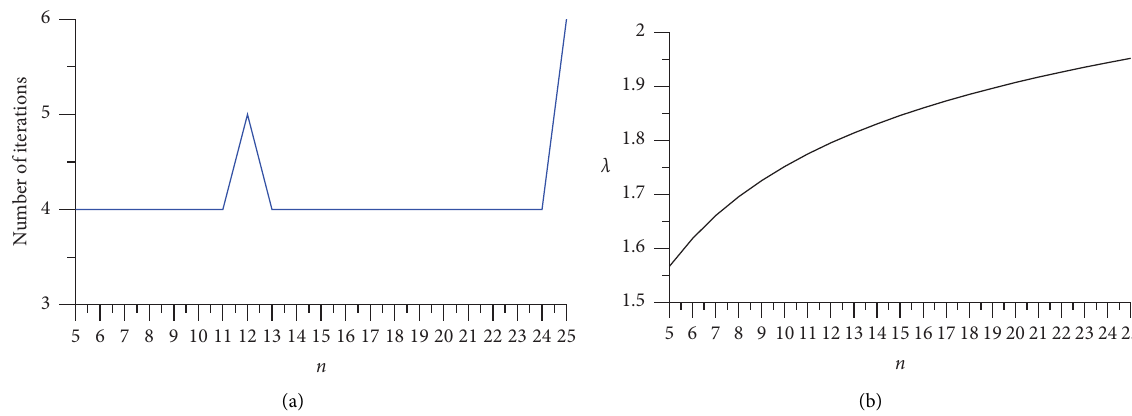
Figure 4: For Example 3, (a) showing the number of iterations spent in the NQM, and (b) the eigenvalues for diferent n